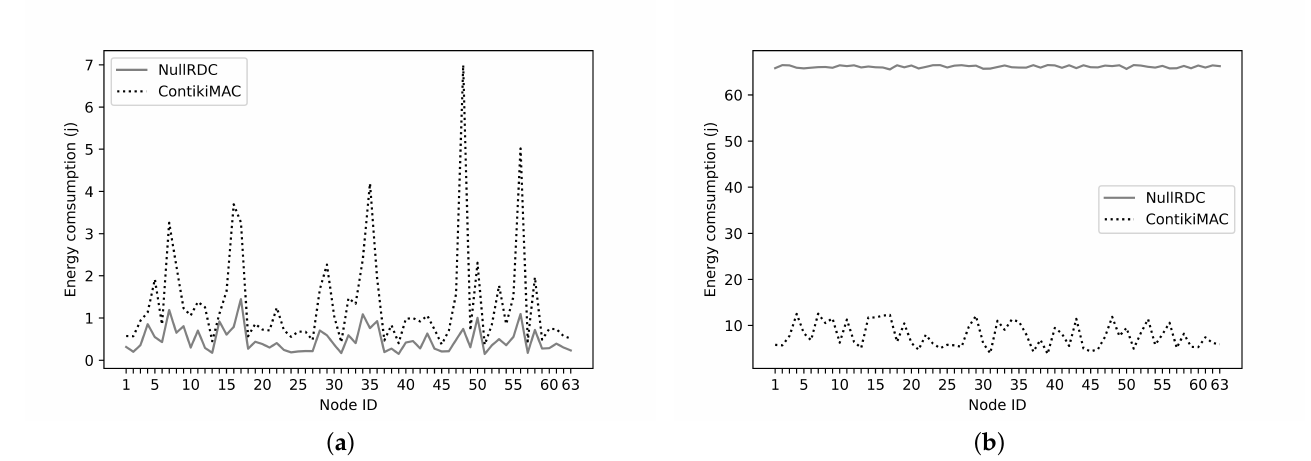
Figure 16. ( a ) Total Consumed energy at CPU on , CPU lpm , and T x modes. ( b ) Consumed energy at R x mode. To analyze the energy consumption further, Figure 17 shows the per node total energy consumption. The plotted results include CPU on , CPU lpm , R x , and T x modes. It can be seen from the figure that the energy usage using NullRDC is approximately 66.6 Joules on average which is almost 7.2 times higher than ContikiMAC.